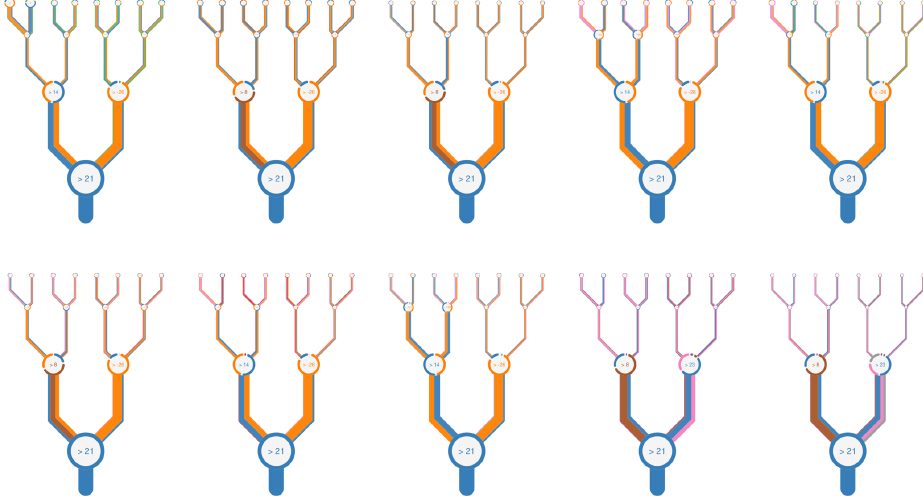
Figure A5. Representation of all forests within the 10-member ensemble (also shown as thumbnails in Fig. 3c). The branches are coloured by percentage of each variable that drives the decision at a given node. The thickness of branches gives the average throughput of the dataset through a given node. Variable names are coloured as per the following coloured text: temperature (blue, ◦ C), depth (orange,metres), chlorophyll a (green, mgm − 3 ), salinity (pink, PSU), nitrate (brown, µgm − 3 ), mixed layer depth (MLD; purple, metres), phosphate (red, µgm − 3 ), and shortwave radiation (grey, Wm − 2 )